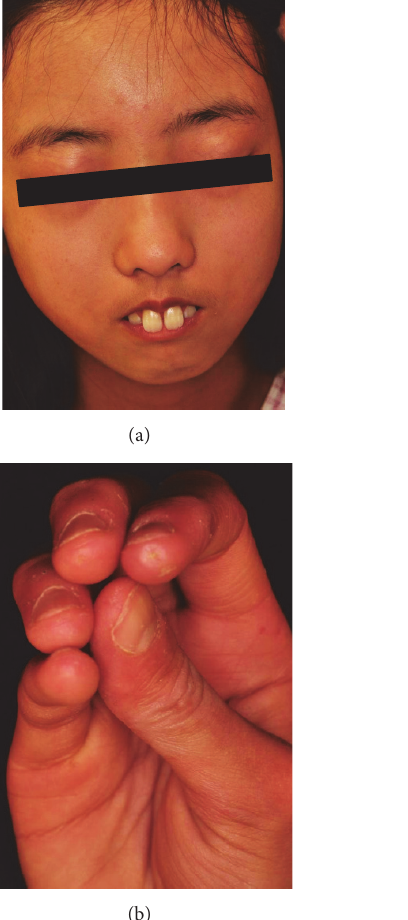
Figure 1: (a) A mask-like face and (b) digital pitting scarring on the right index finger.